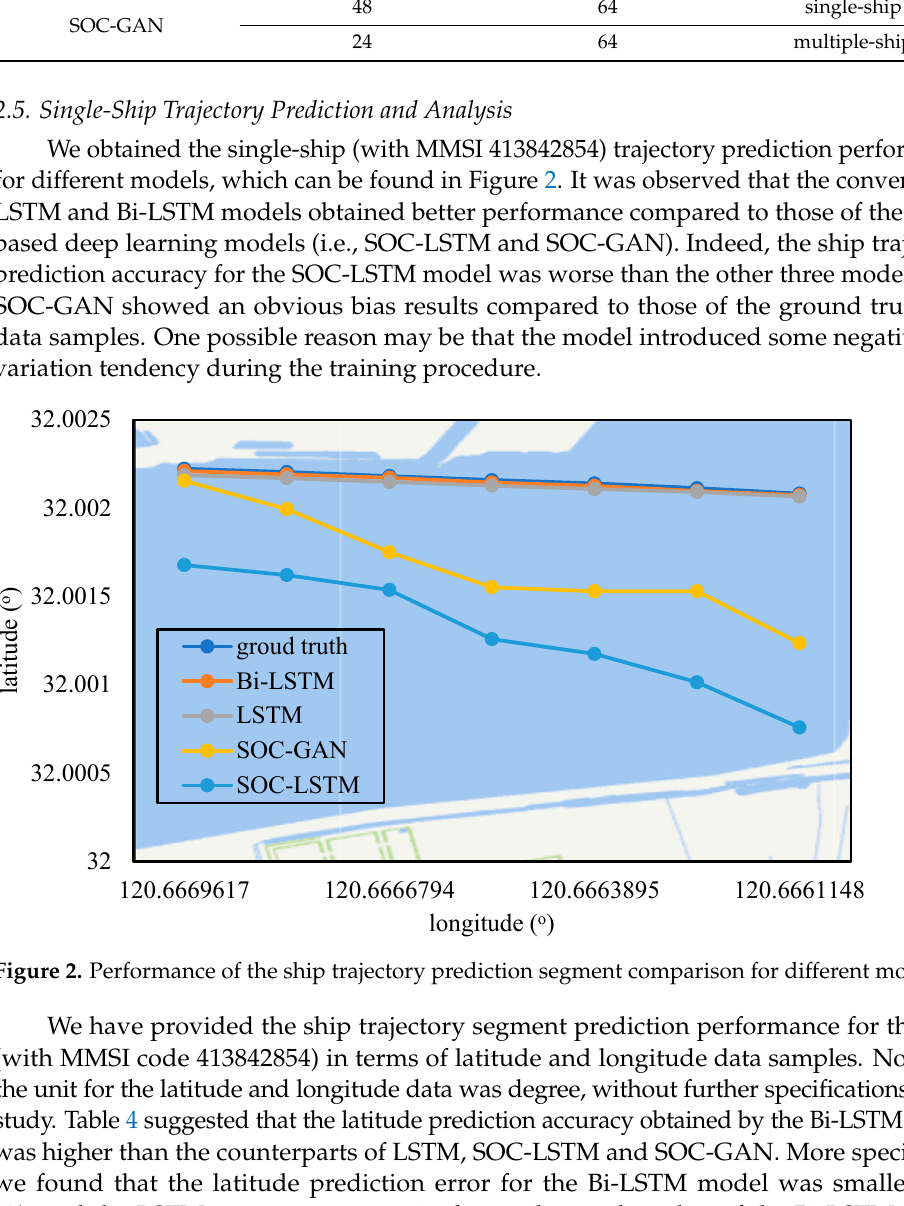
Table 5. Ship trajectory segment prediction performance on longitude data samples.